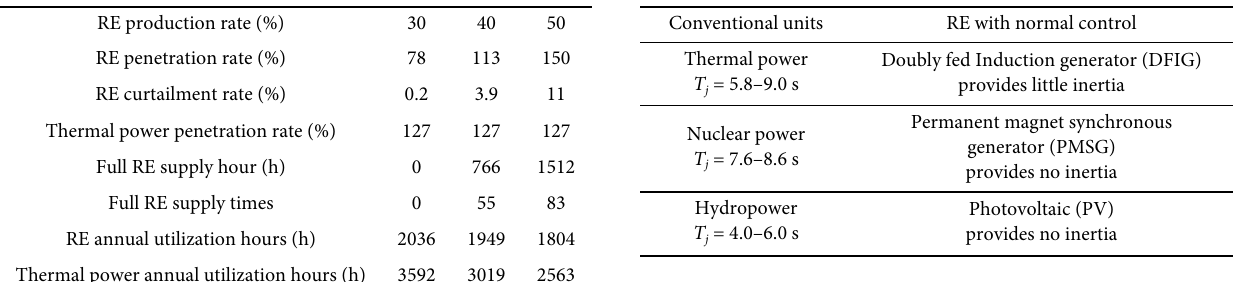
Table 4 Results of case study 2 Table 5 Comparison of rotational inertia in different power sources